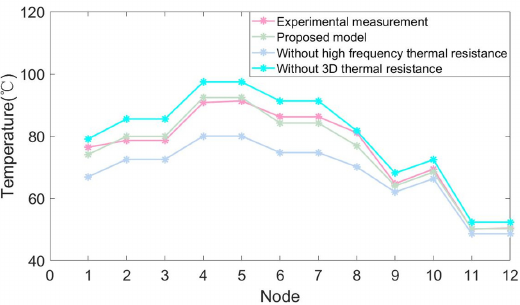
Figure 14. The comparison among the proposed model, the model without high-frequency thermal resistance, the model without three-dimensional thermal resistance and the experimental result under the voltage of ±1050 V.